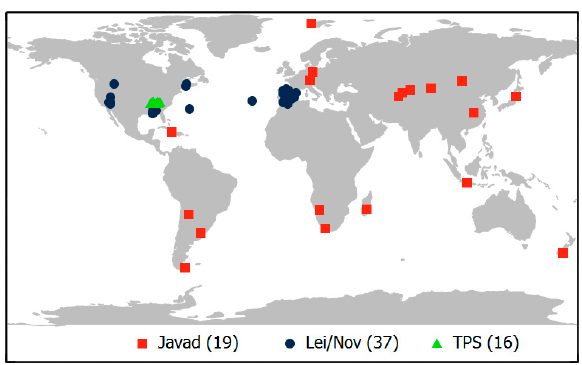
Figure 5. Geographical distribution of stations providing RINEX-2 files with L2 quarter cycle problems.